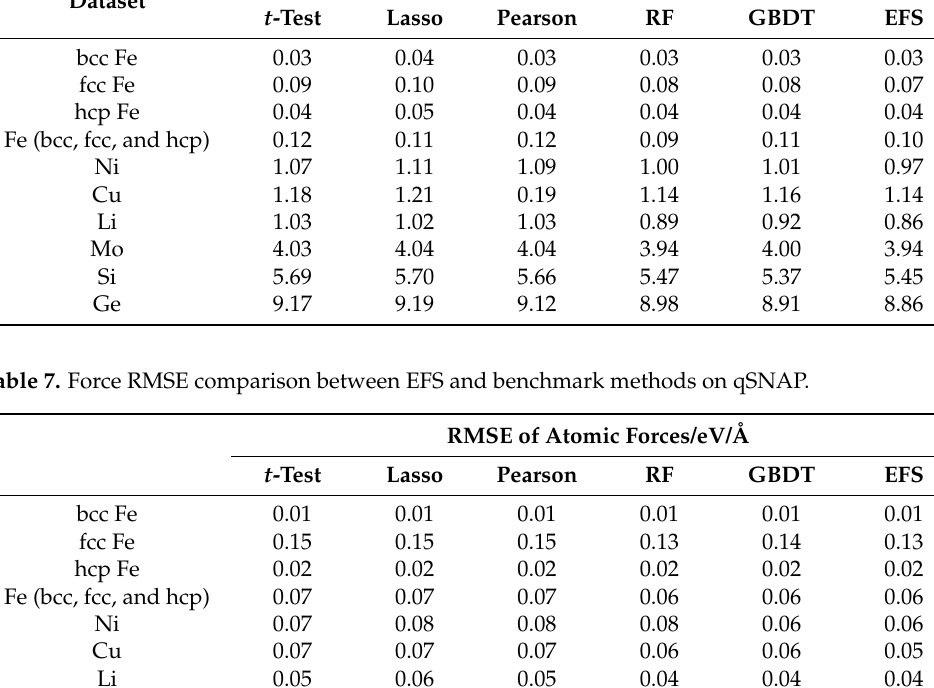
Table 6. Energy RMSE comparison between EFS and benchmark methods on qSNAP. Dataset